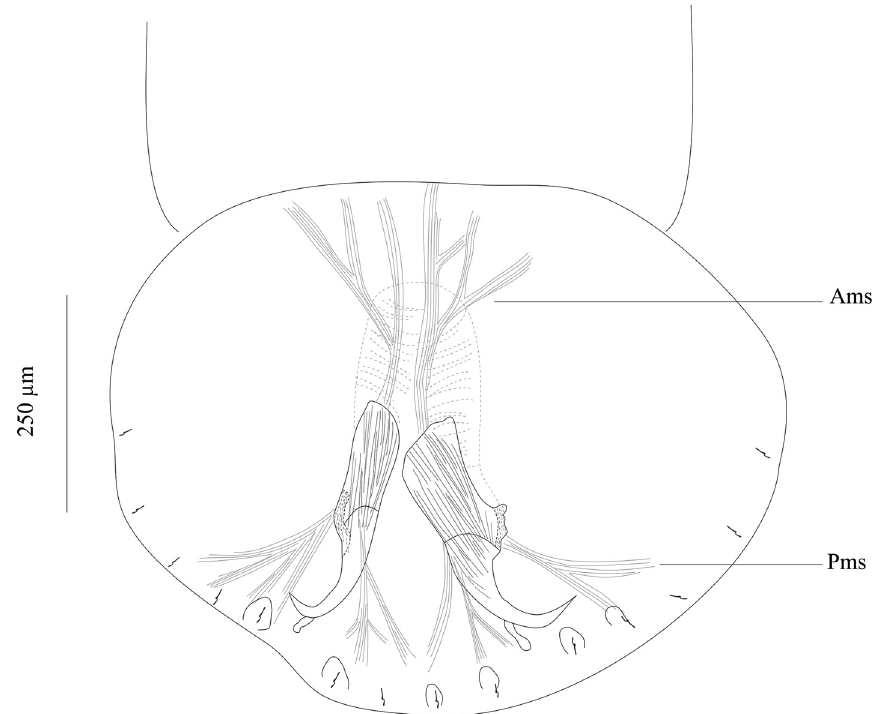
Figure 4. Muscles connected to the hamuli. Abbreviations: Ams, anterior muscles; Pms, posterior